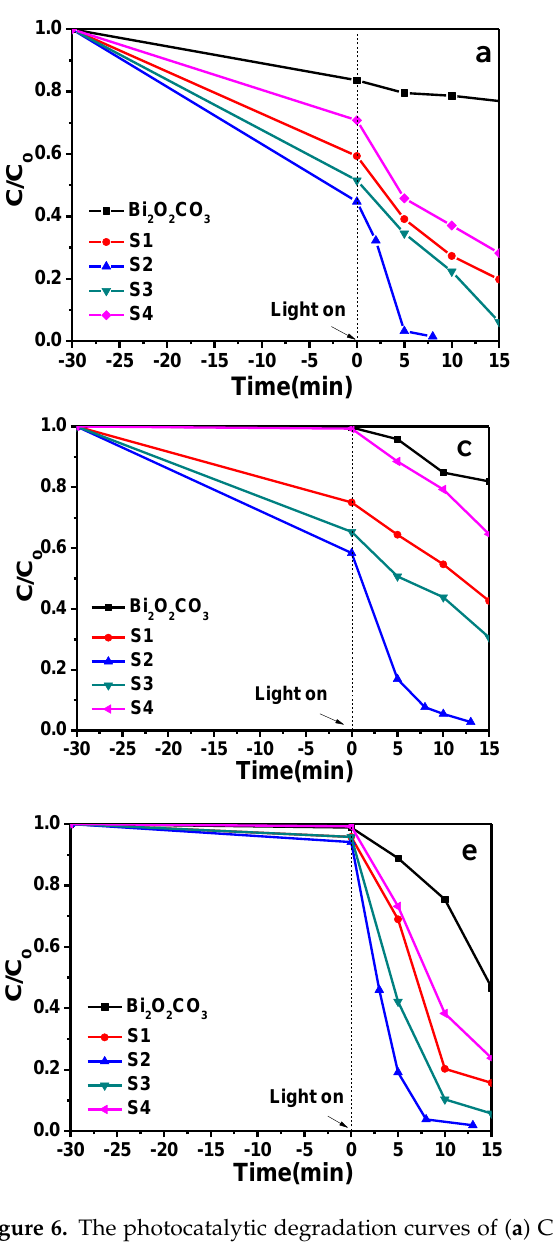
Figure 6. The photocatalytic degradation curves of ( a ) Cr(VI), ( c ) MO and ( e ) BPA by different photocatalysts. UV-vis absorption spectrum of ( b ) Cr(VI), ( d ) MO and ( f ) BPA using S2 as a photocatalyst under solar-light irradiation.